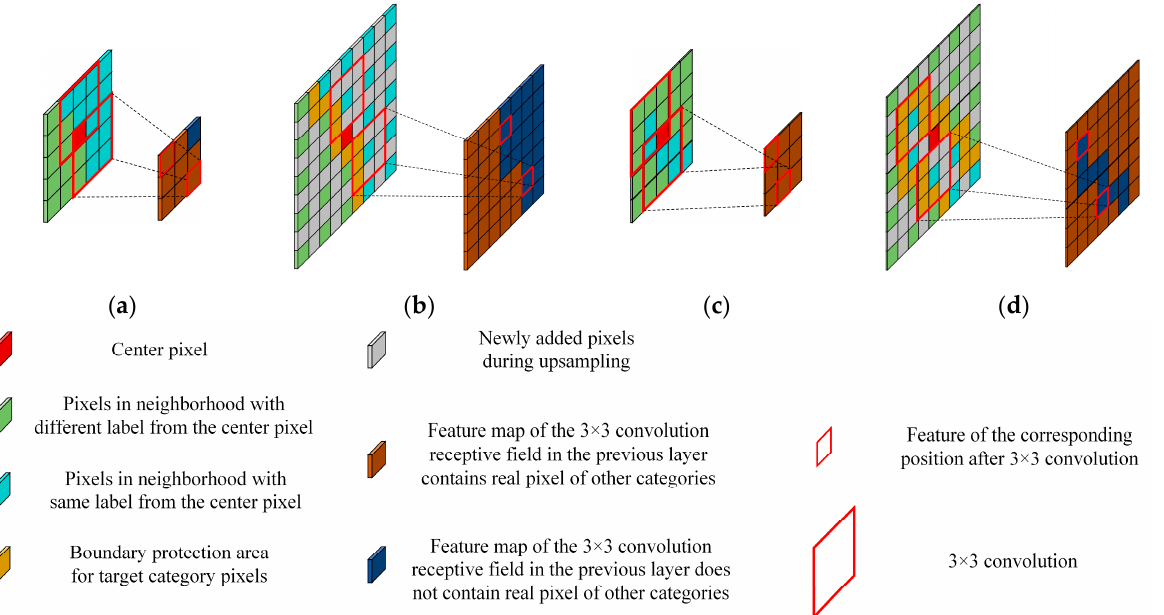
Figure 2. Subpixel operation for different datasets, ( a ) (128, 151) pixel in Salinas with 5 × 5 spatial scale; ( b ) subpixel operation on ( a ); ( c ) (963, 280) pixel in Pavia Center with 5 × 5 spatial scale; ( d ) subpixel operation on ( c ).